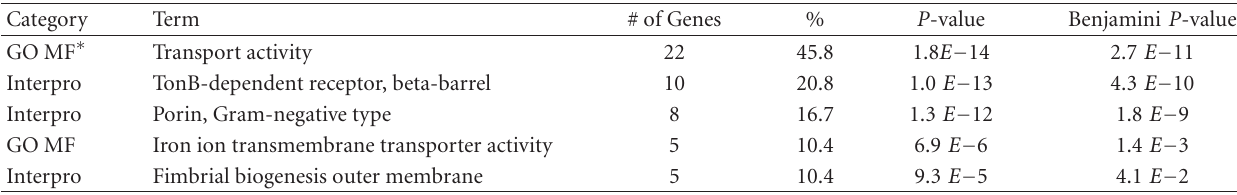
Table 3: Selected function annotations significantly enriched for UPEC vaccine candidates based on DAVID analysis.